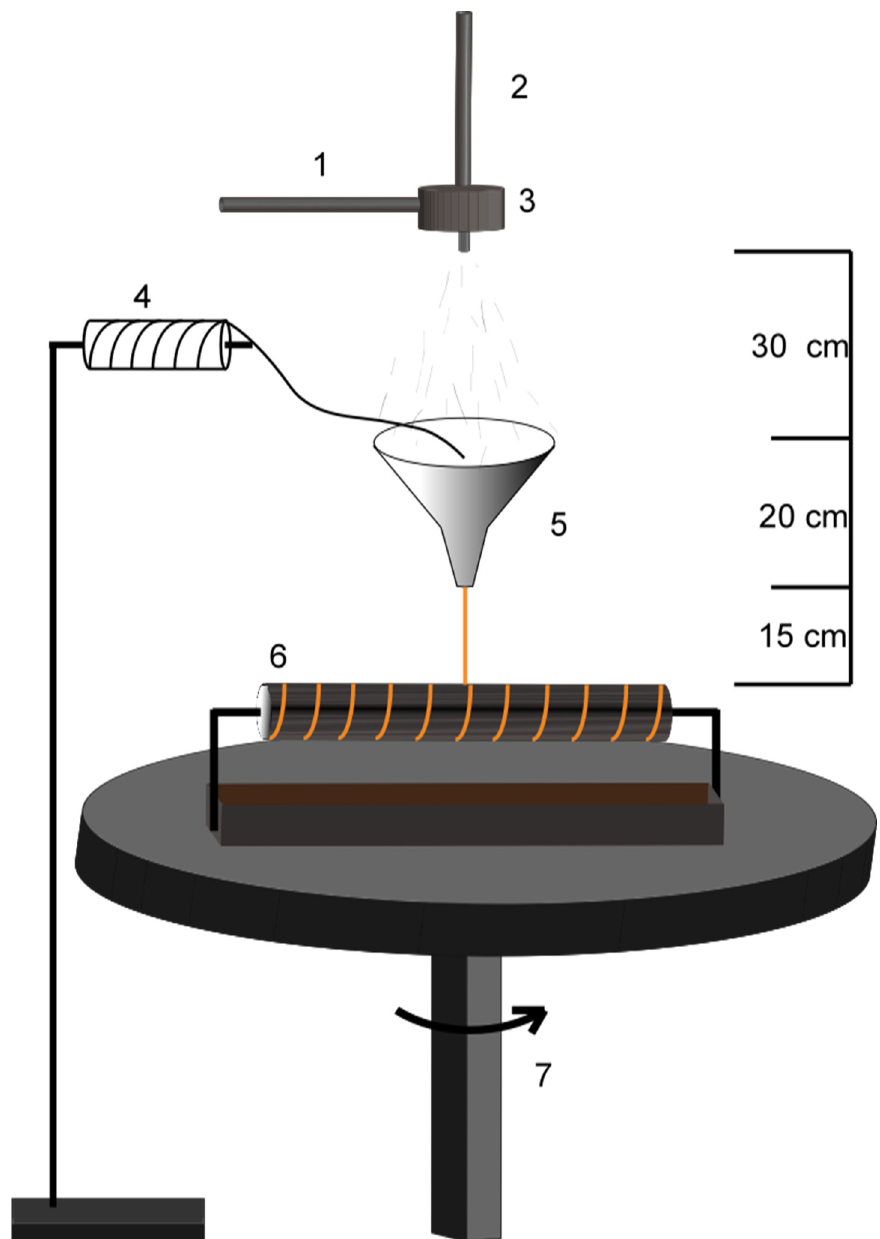
Figure 1. Schematic diagram of the Solution blowing process (1.solution; 2.air flow; 3.nozzle; 4.bobbin; 5.funnel; 6.rotate collector; 7. rotate round table).